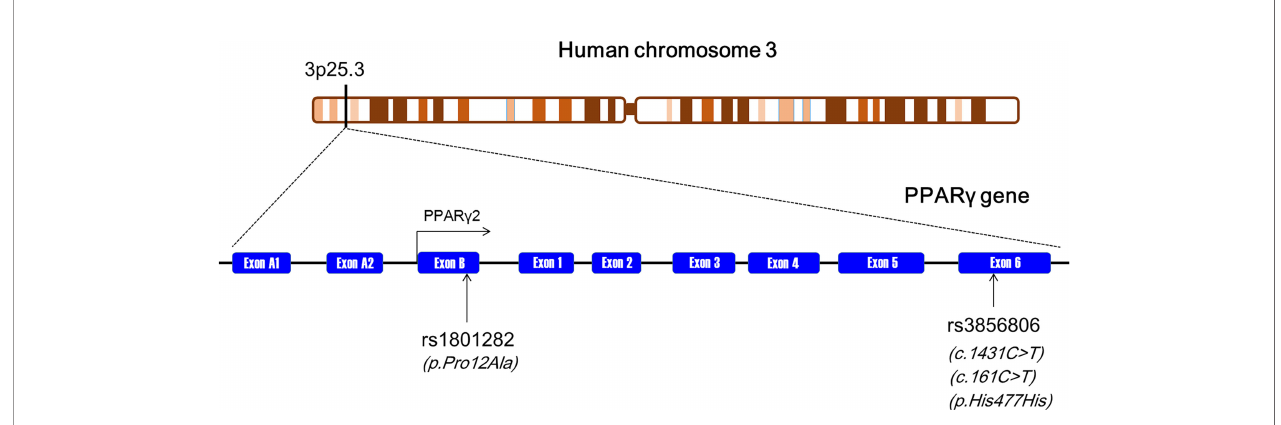
FIGURE 1 | The genomic landscape of the rs1801282 and rs3856806 polymorphisms in PPAR g gene. PPAR g , peroxisome proliferator-activated receptor